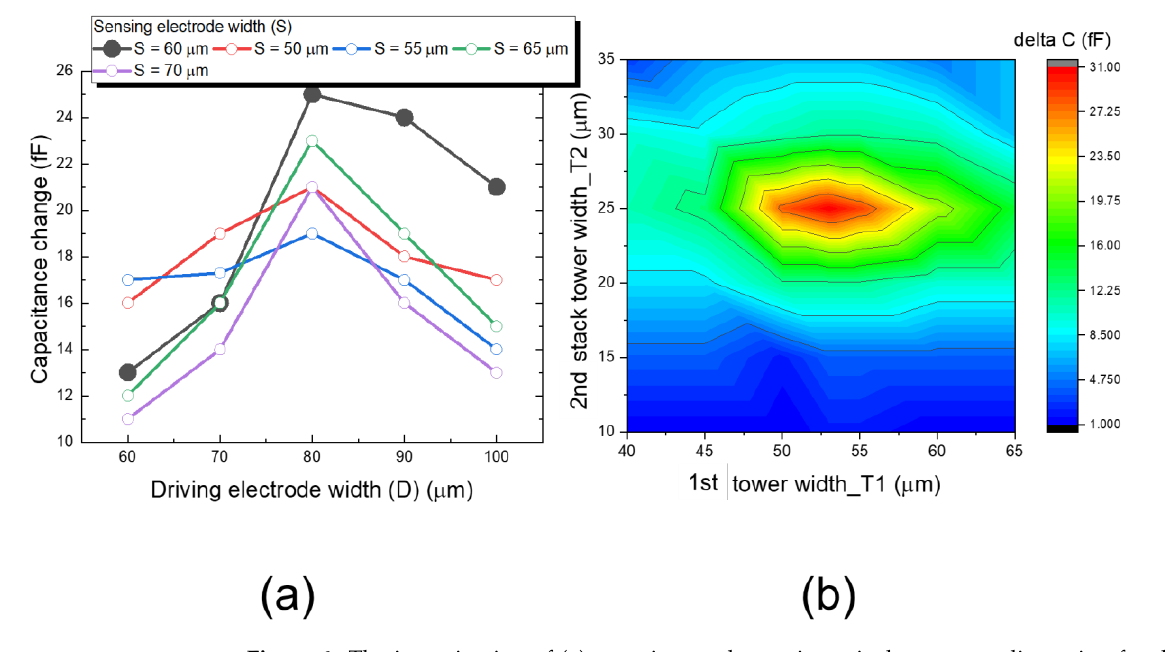
Figure 6. The investigation of ( a ) capacitance change in a pixel geometry dimension for driving electrode width (D) against sensing electrode width (S), and ( b ) contour field plot for 1st stacked tower width (T1) against 2nd stacked tower width (T2).